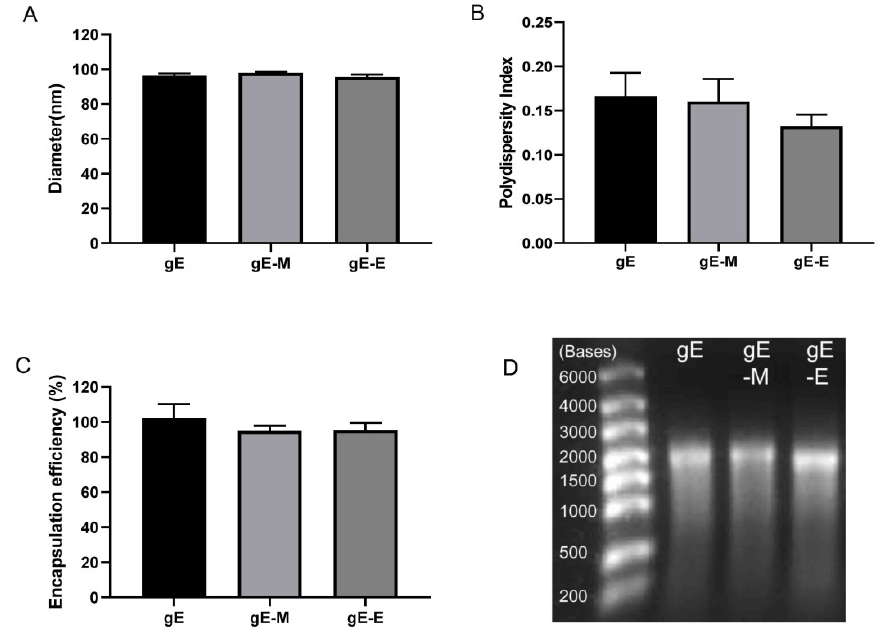
Figure 1. Characterization of LNP mRNA vaccines. ( A ) Diameters tested by size analyzer; ( B ) polydispersity index of LNPs; ( C ) mRNA encapsulation efficiency; ( D ) loaded mRNA detected with a 1% denatured agarose gel.